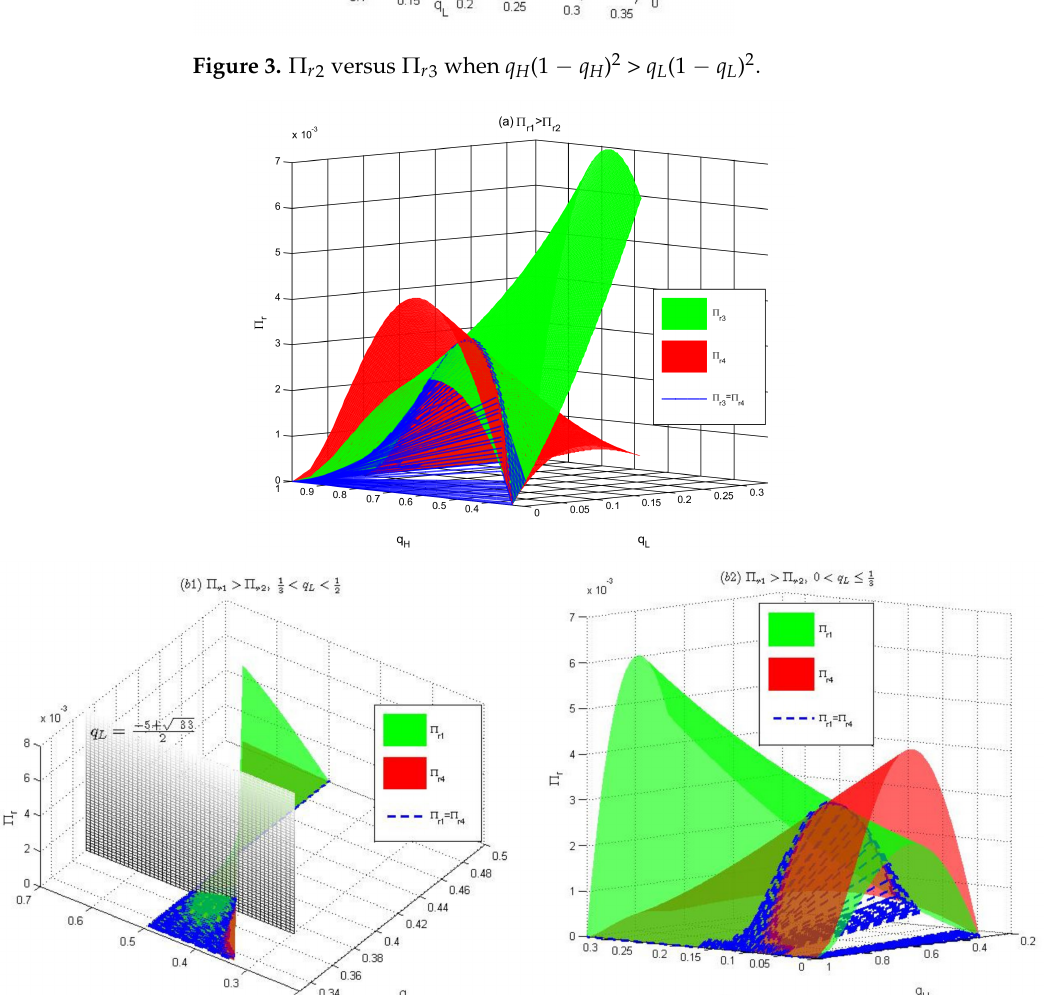
Figure 4. Π r 3 versus Π r 4 versus Π r 1 when q H (1 − q H ) 2 < q L (1 − q L ) 2